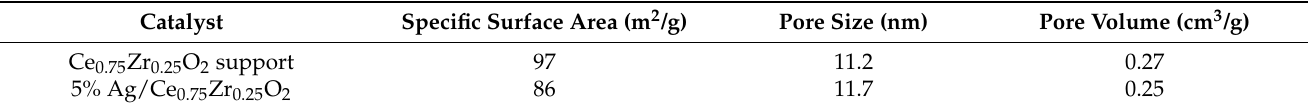
Table 1. Textural properties for the support before and after silver loading.